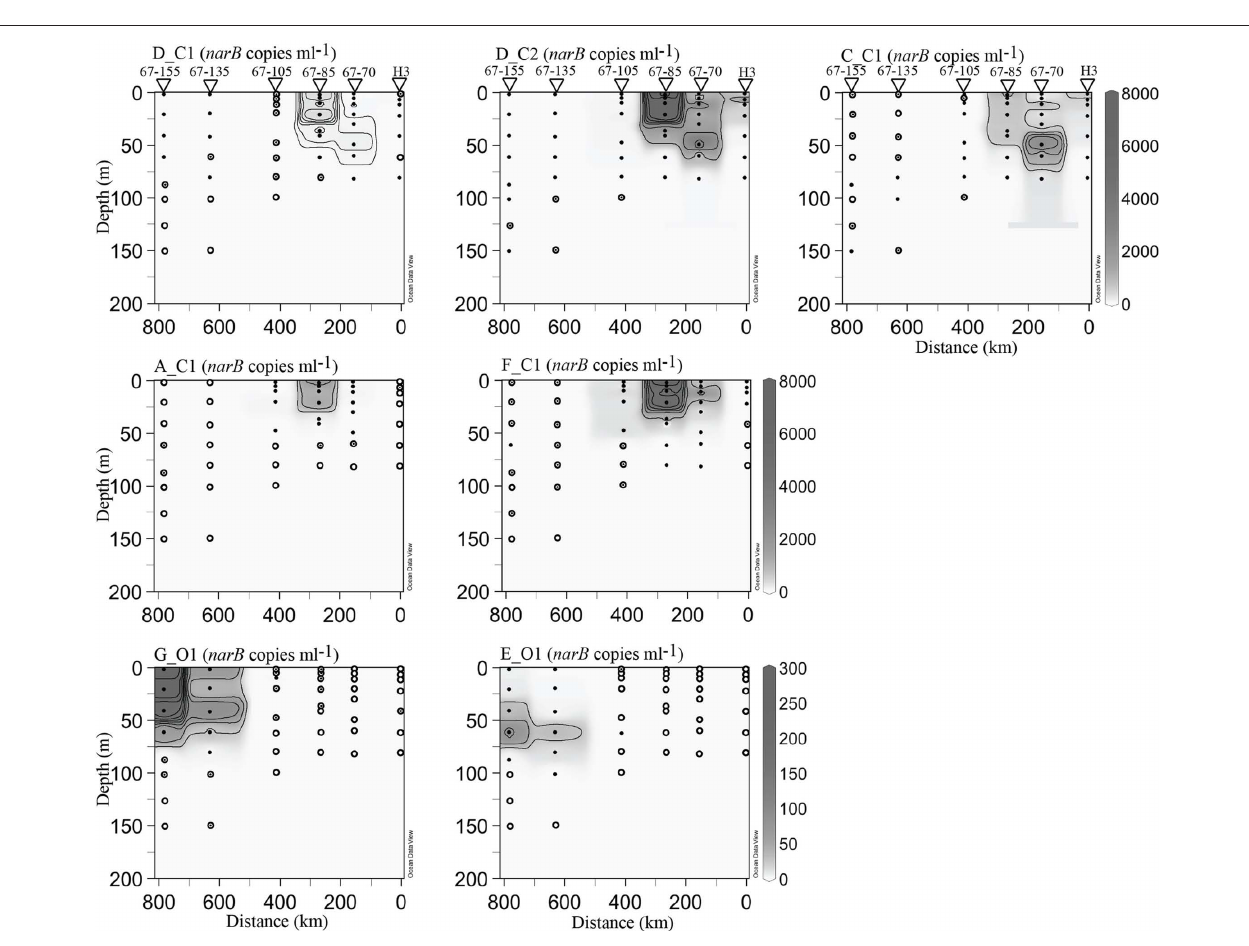
subgroups were undetected. Note the different abundance scales used for coastal (C) and open-ocean (O) subgroups. Contour intervals vary based on the narB subgroup plot: E_O1 and, G_O1 25 narB copies ml − 1 ; D_C1, 50 narB copies ml − 1 ; A_C1 and C_C1, 500 narB copies ml − 1 ; D_C2 and F_C1, narB 1000 copies ml −